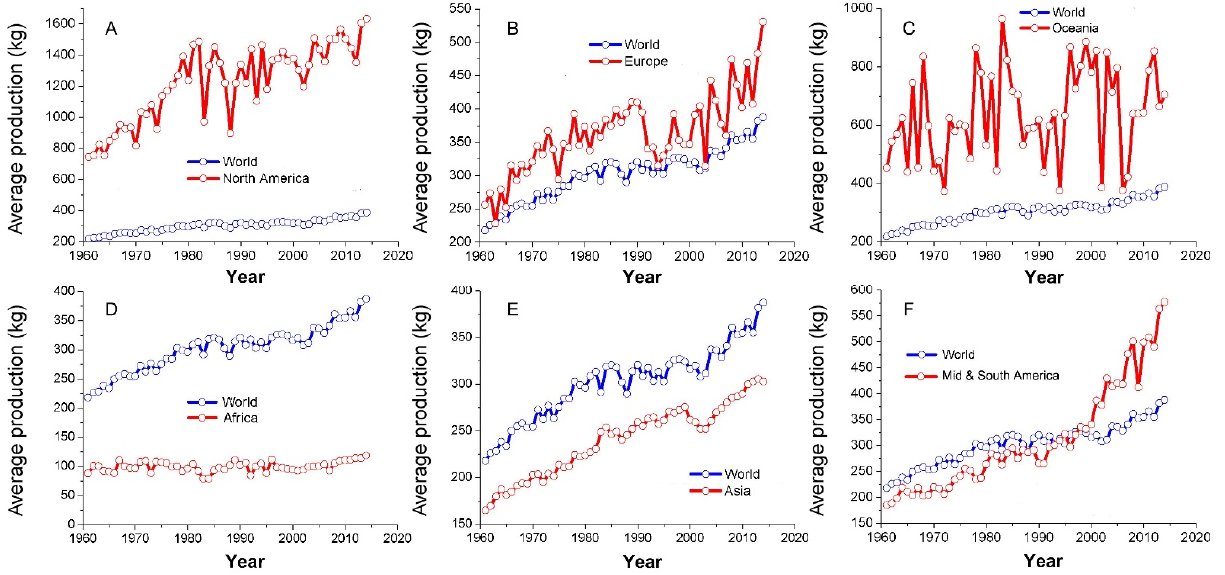
Figure 1. The world average grain production change in different continents (( A ) North America, ( B ) Europe, ( C ) Oceania, ( D ) Africa, ( E ) Asia, and ( F ) Mid and South America) from 1960 to 2014.